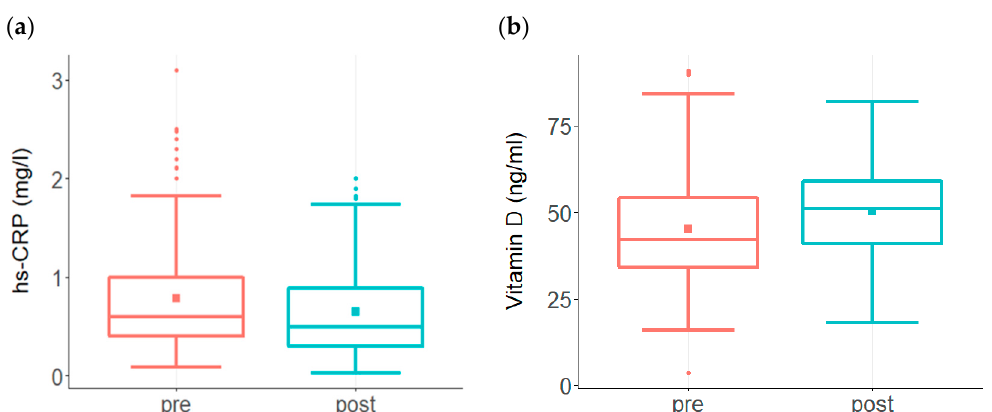
Figure 1. Changes in risk factor levels among participants enrolled in the ReCODE program. ( a ) A significant decline in hs-CRP ( p < 0.001) was observed in the treatment group ( n = 177) compared to the high levels at baseline. While baseline hs-CRP ranged from 0.09 to 3.1 with a mean of 0.8, post-treatment levels ranged from 0.03 to 2 with a mean of 0.64. The baseline median score was 0.6, post-treatment median score was 0.5 ( b ) Baseline Vit D levels among participants ( n = 207) ranged from 3.6 to 91 with a mean of 45 and median score of 42, post-treatment levels ranged from 18 to 82 with a mean of 50 and median score of 52. This increase in the post-treatment group was statistically significant ( p < 0.001).